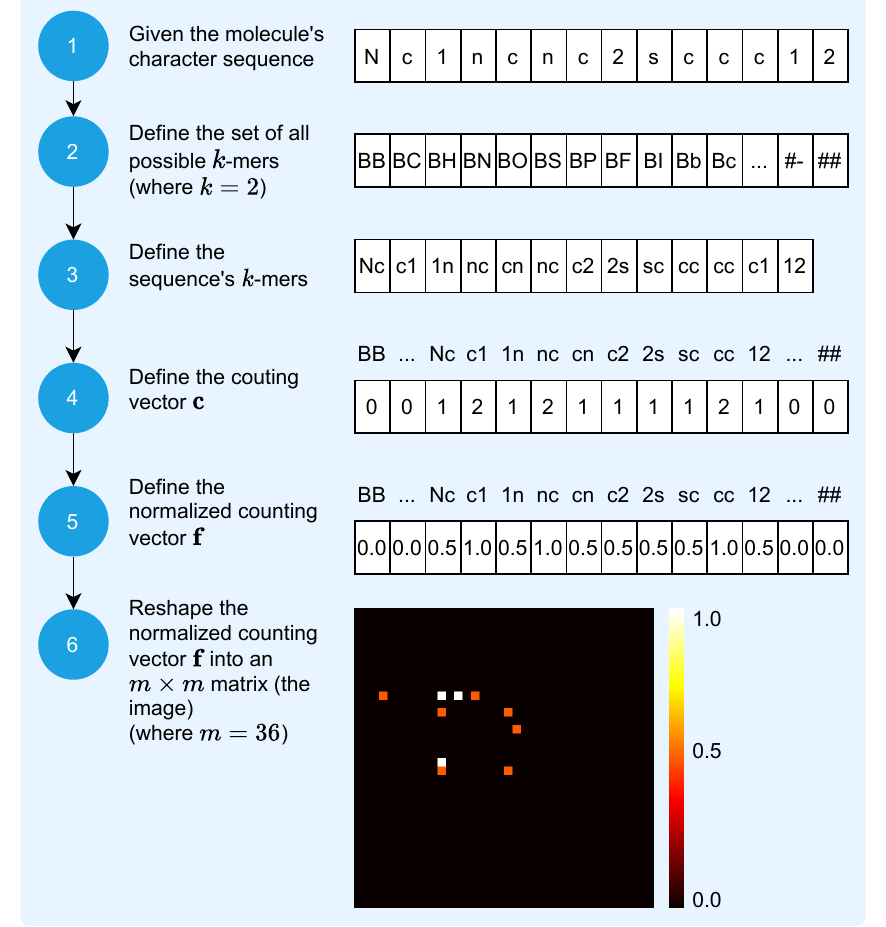
Figure 2. Molecule sequence to image